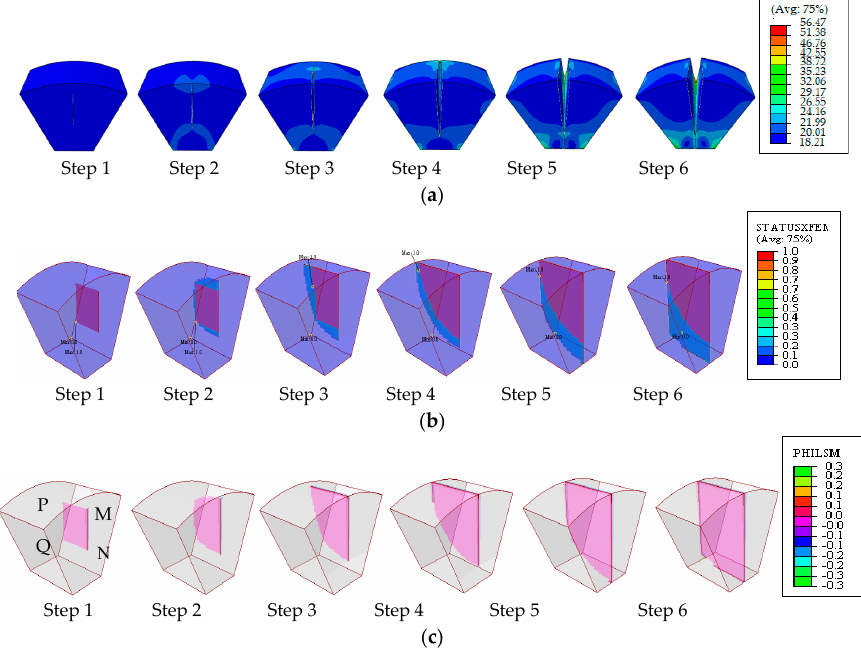
Figure 4. Contour plots of ( a ) Mises stress; ( b ) StatusXFEM; ( c ) PHILSM.